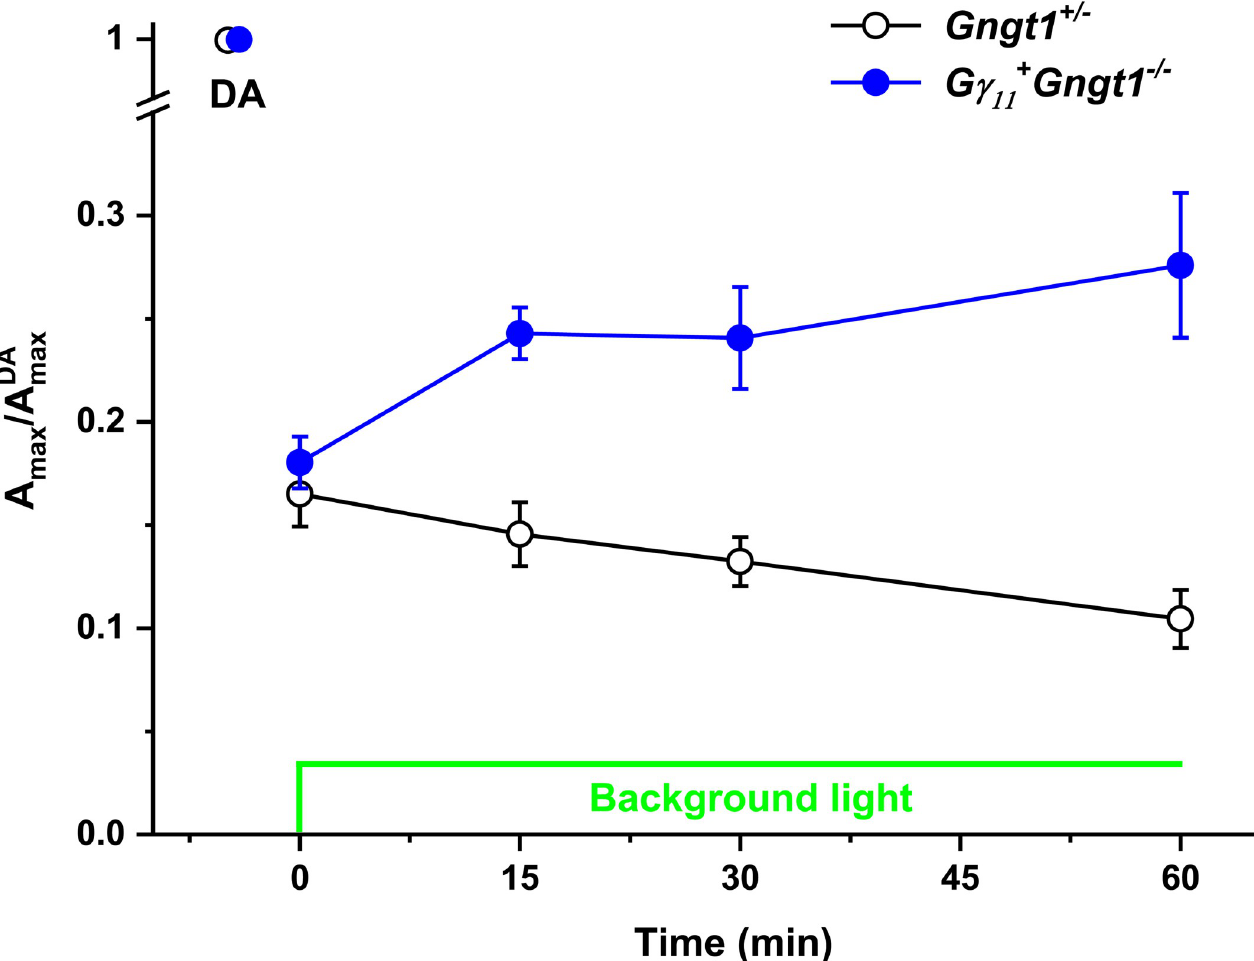
Fig 9. Changes of rod-driven maximal ex vivo transretinal ERG responses in control ( Gngt1 +/- ) (n = 4) and transgenic G γ 11+Gngt1 -/- (n = 4) retinas. Retinas were exposed to prolonged moderate non-saturating 505-nm background light activating ~830 visual pigment molecules (R � ) per rod per second initially. All maximal responses were normalized to corresponding dark-adapted response amplitudes (A DA max ) and population-averaged. The onset and duration of background light are shown in green.